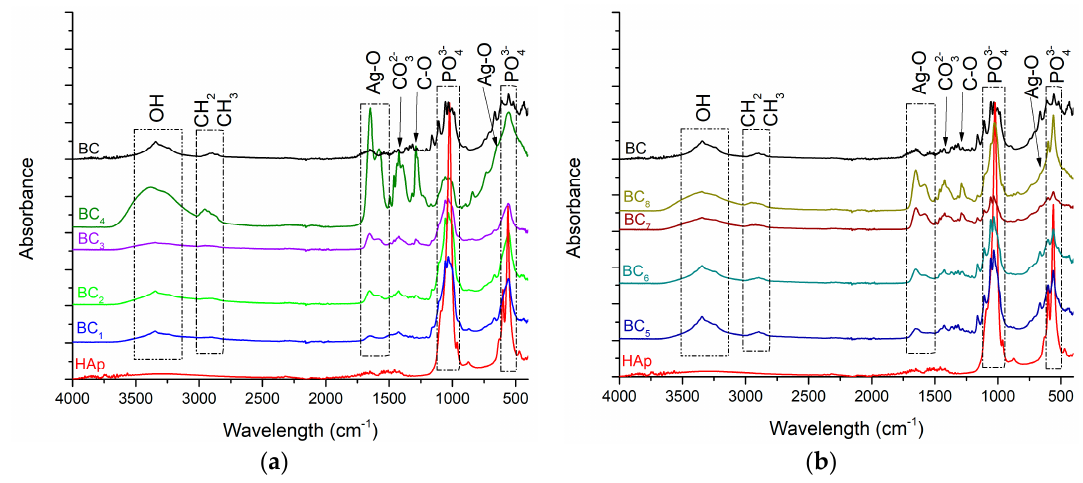
Figure 6. FT-IR analysis corresponding to the ( a ) in situ and ( b ) ex-situ composite samples.